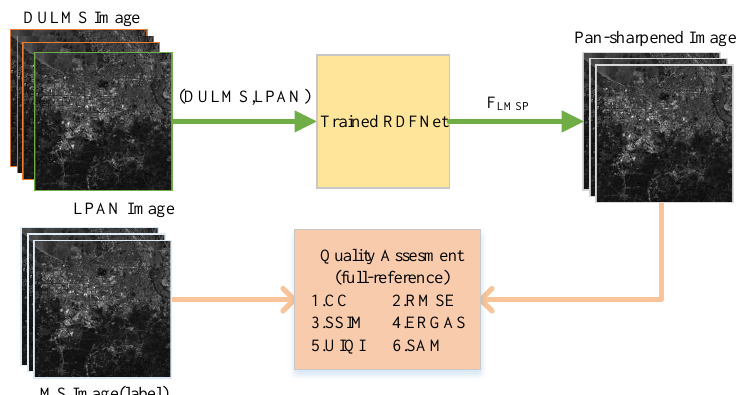
Figure 5. Testing and evaluating RDFNet with DULMS and LPAN images with reduced resolution.